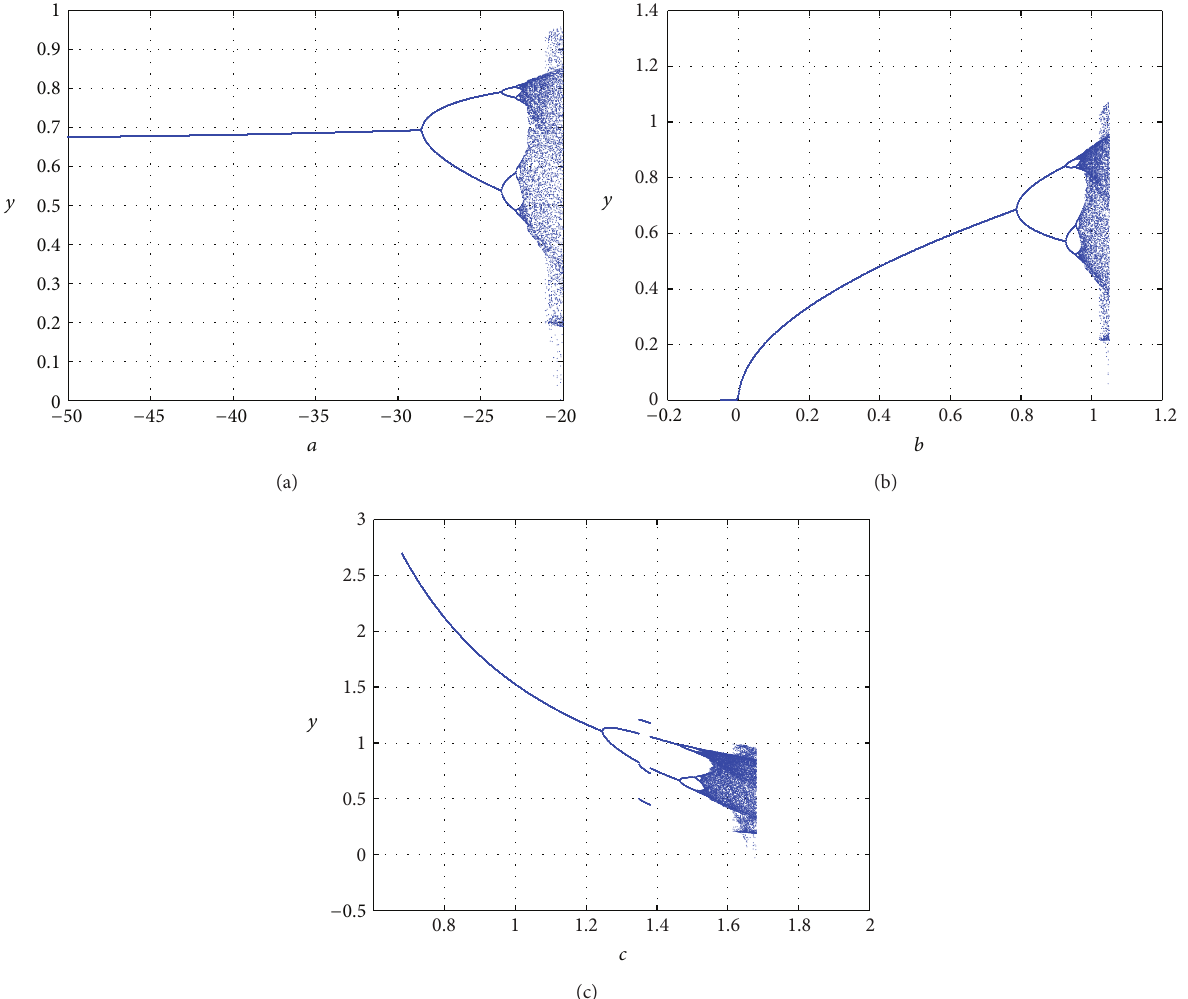
Figure 2: Bifurcation diagram of system (1): (a) 𝑏 = 1 and 𝑐 = 1.68 , (b) 𝑎 = −20 and 𝑐 = 1.68 , and (c) 𝑎 = −20 and 𝑏 = 1